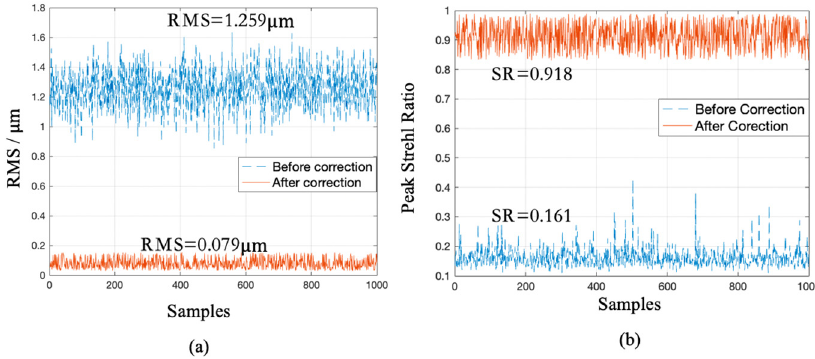
Figure 4. RMS ( a ) and SR ( b ) before and after correction of 1000 samples in the test set.